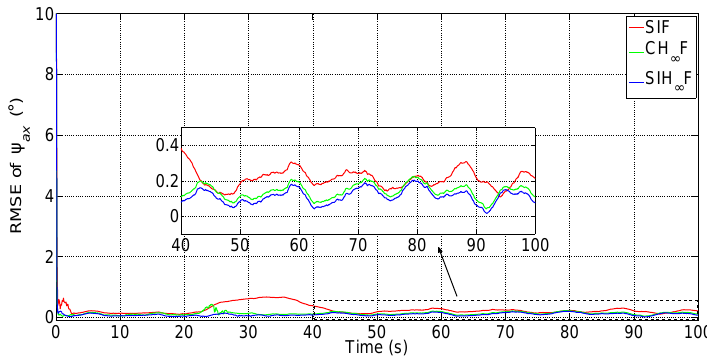
Figure 5. RMSE of ψ ax (the subfigure is the magnification of the estimation result during 40 s–100 s).